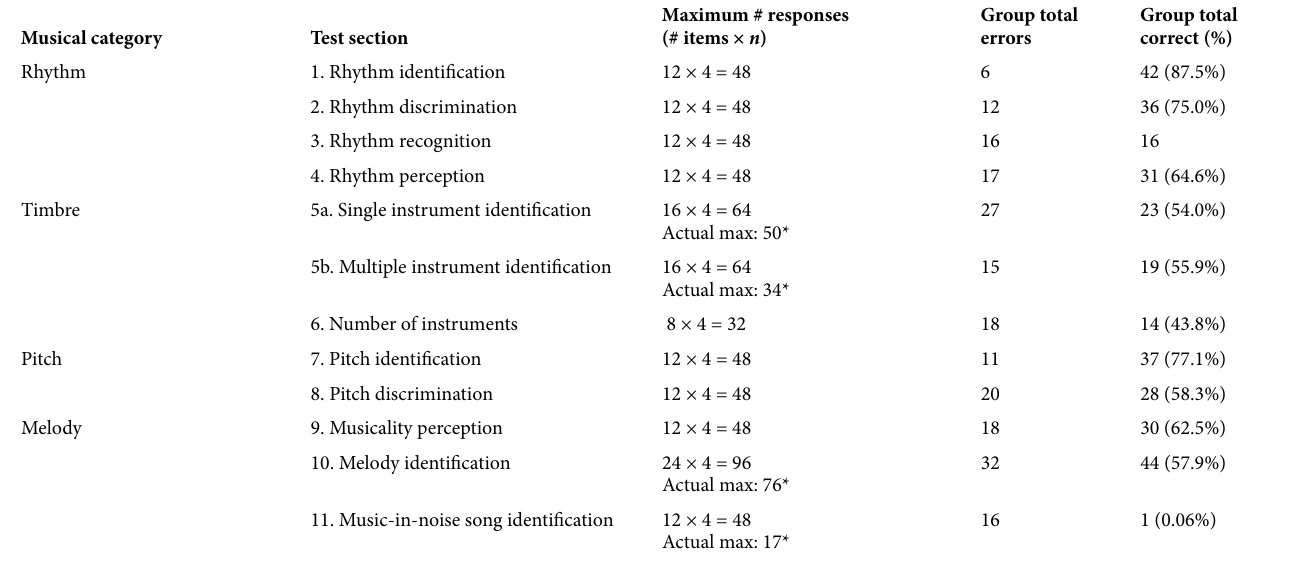
Table VI. Error rates and percentage correct for the first version of the MPT presented to participants with hearing aids ( n =4) Musical category